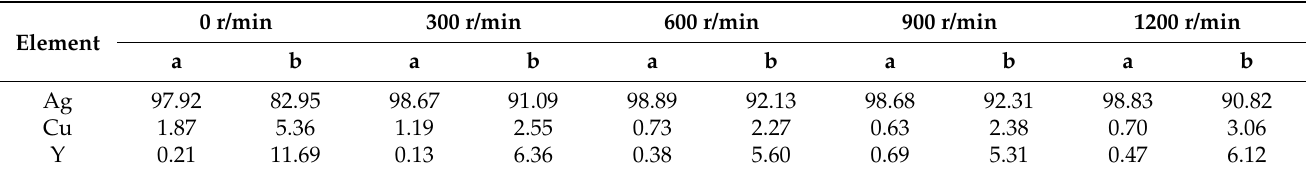
Table 2. Element distribution of the Ag–1.5Cu–1.0Y alloys under different rotation speeds (wt%). Element